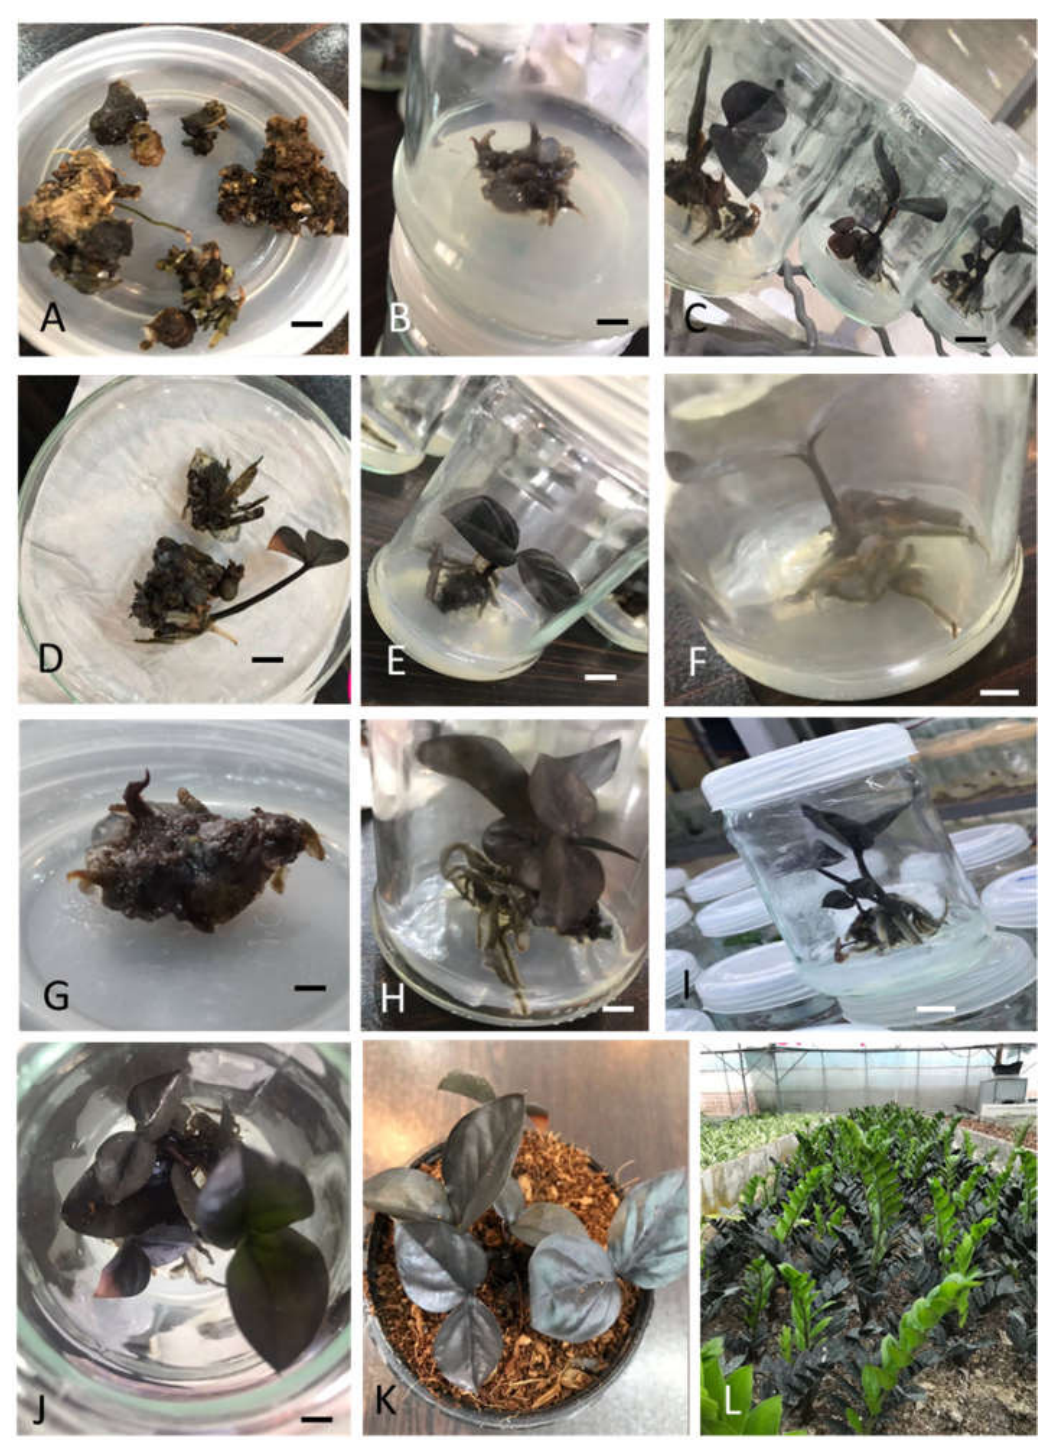
Figure 1. In vitro propagation of Z. zamiifolia ‘Dowon’. Callus production in a medium augmented with 2 mg·L –1 NAA + 1 mg·L –1 BA ( A ) and the PGRs-free control ( B ); development and multiplica- tion of shoots in a medium containing 0.5 mg·L –1 NAA (( C ), left), 1 mg·L –1 NAA + 2 mg·L –1 BA (( C ),